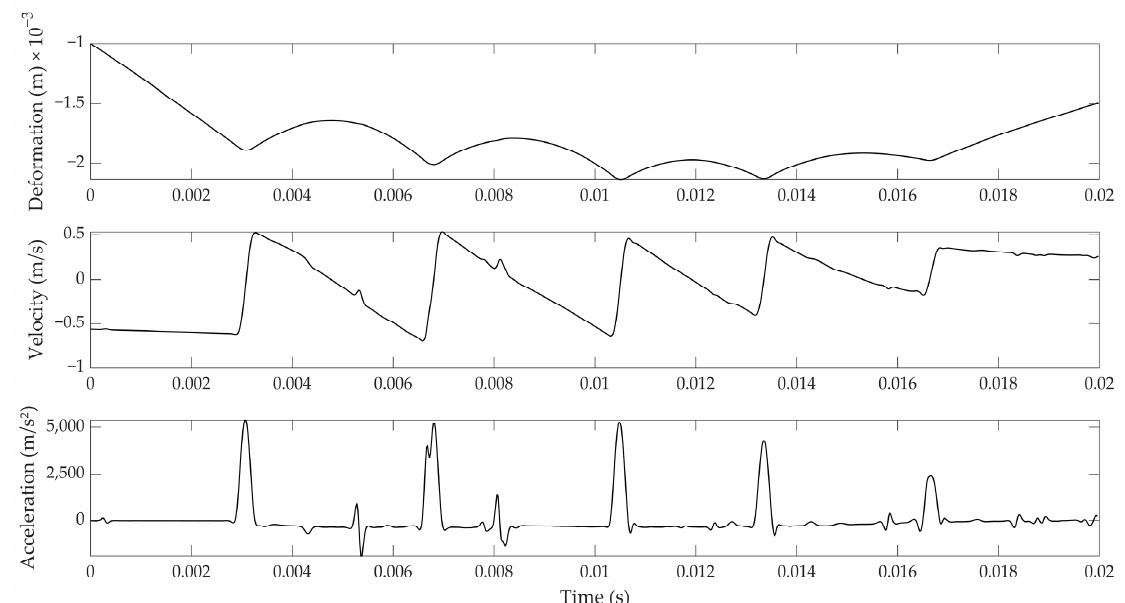
Figure 2. Impact on an intact egg by a small steel ball: Velocity data retrieved from sampling the laser vibrometer at 50 kHz ( middle ); Deformation (m) signal obtained through integration ( top ); and Acceleration signal (m/s²) obtained through derivation ( bottom ).